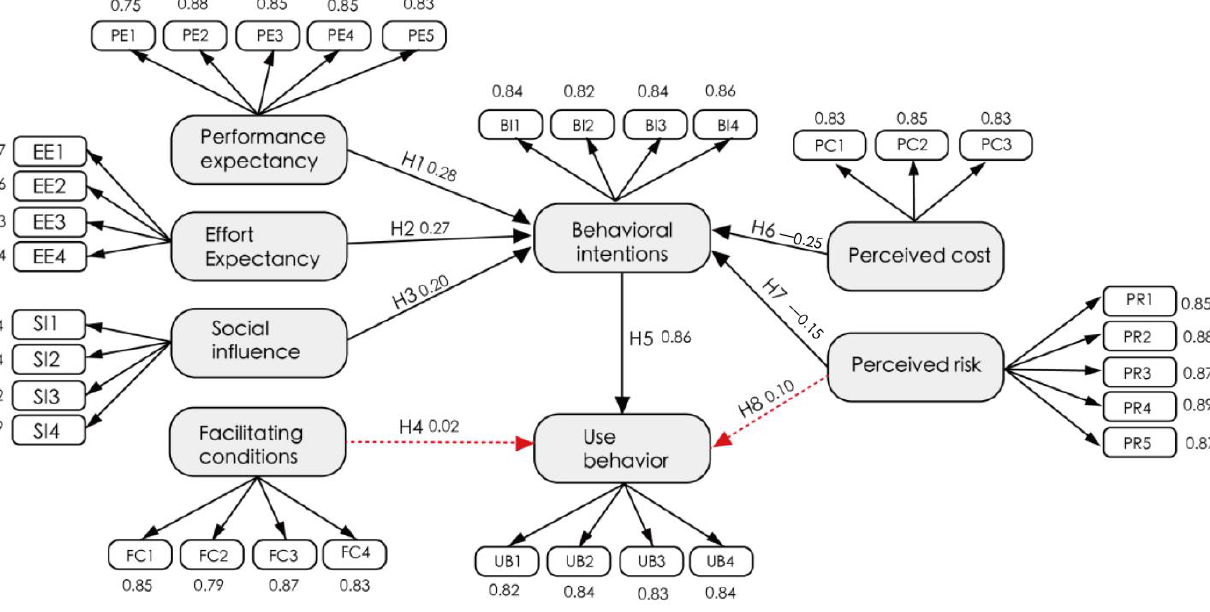
Figure 4. Research Model